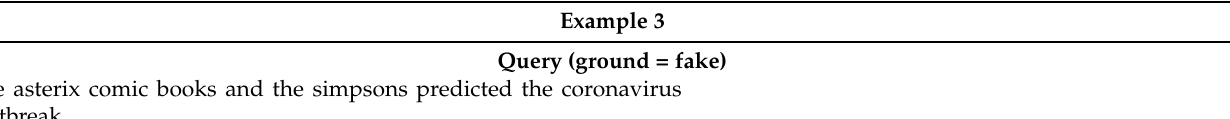
Table 5. Examples of answers provided by the system for different input queries (case study n.